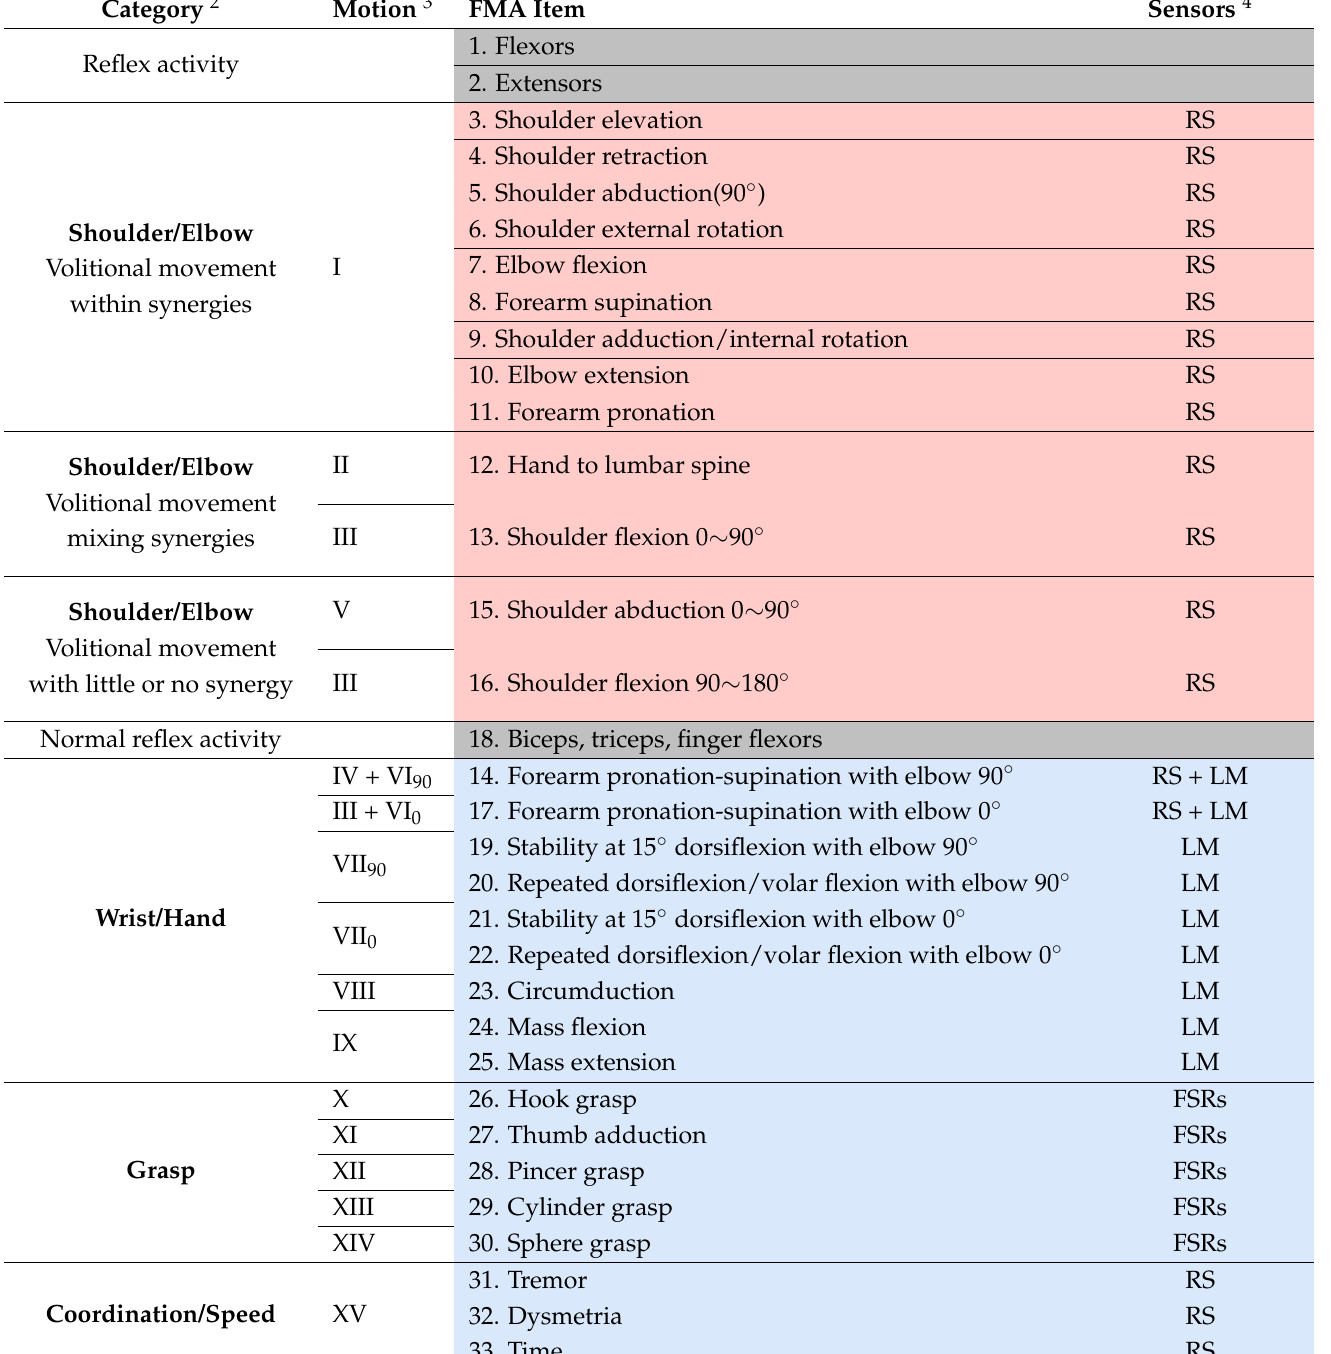
Table 1. Target FMA items and Grouping 1